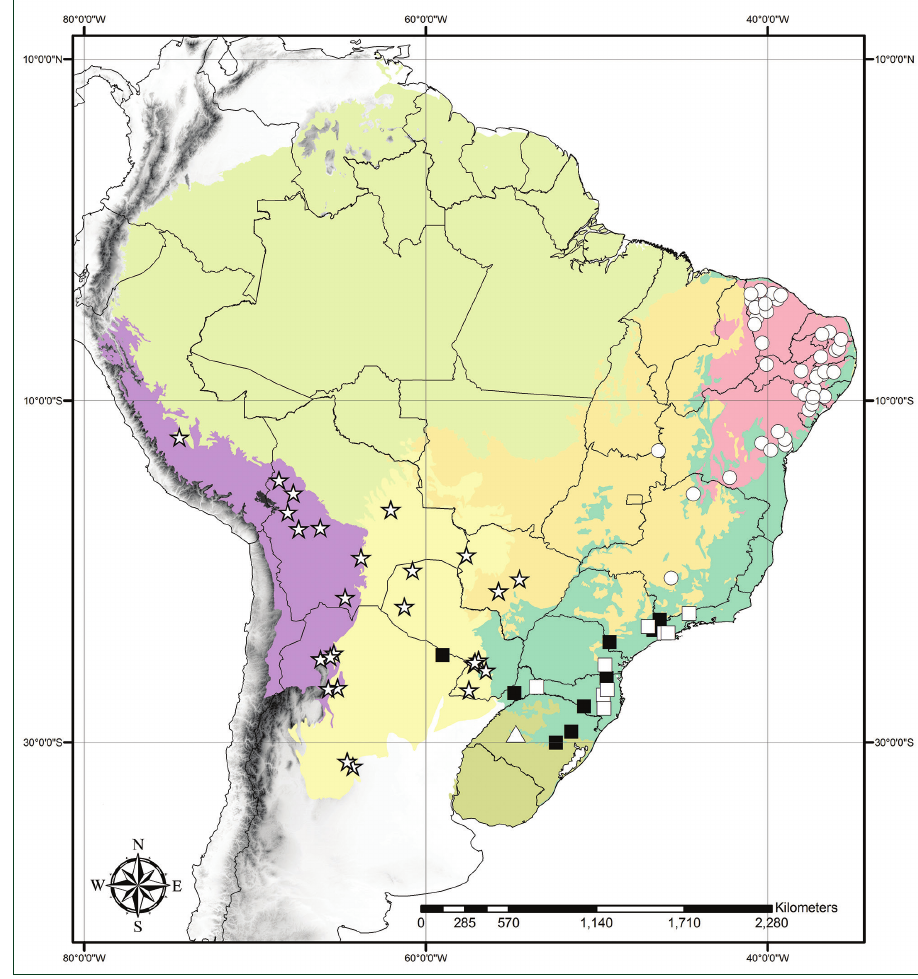
Figure 8. Distribution map of studied Tradescantia L. in the South American domains. Full squares– T. crassula ; White squares– T. chrysophylla ; Triangles– T. valida ; Circles– T. ambigua ; Stars– T. boliviana . Light green– Amazon Forest; Orange– Cerrado; Red– Caatinga; Yellow– Chaco and Pantanal; Olive- green– Pampa; Dark green– Atlantic Forest; Purple– Andean